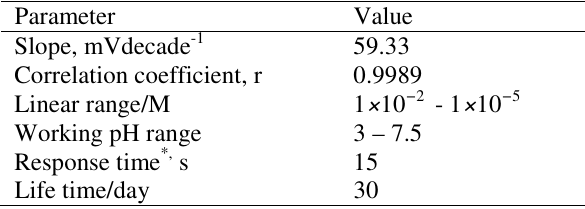
Table 2. Critical response characteristics for RTH-selective